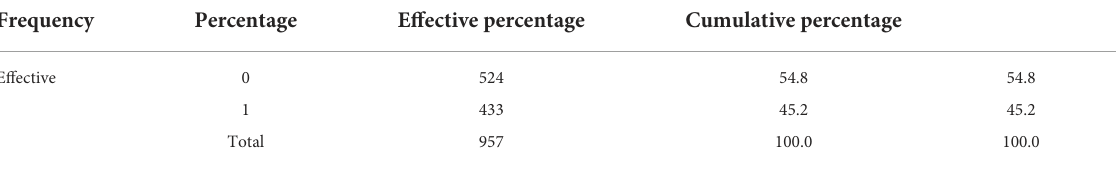
TABLE 4 Residents’ willingness to migrate from the secondary disaster area.